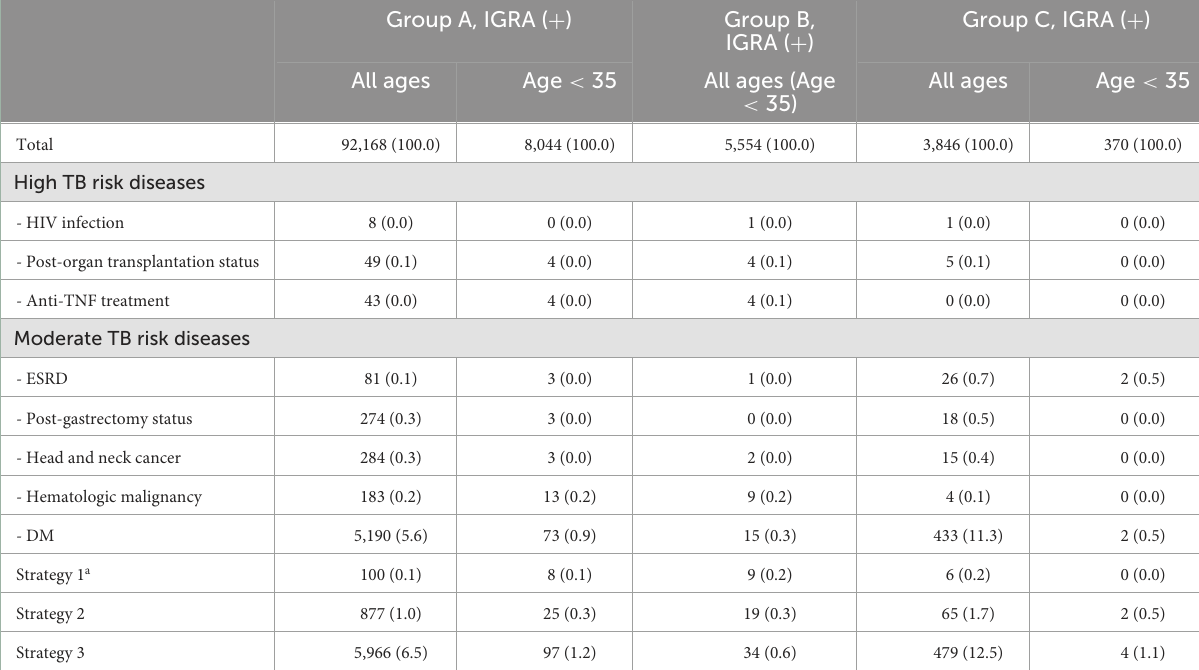
TABLE 6 Coverage rate of current LTBI strategy targeting for high or moderate TB risk diseases among the participants with positive IGRA result in each group. Group A, IGRA ( + ) Group B, Group C, IGRA ( + ) IGRA ( + ) All ages Age < 35 All ages (Age <